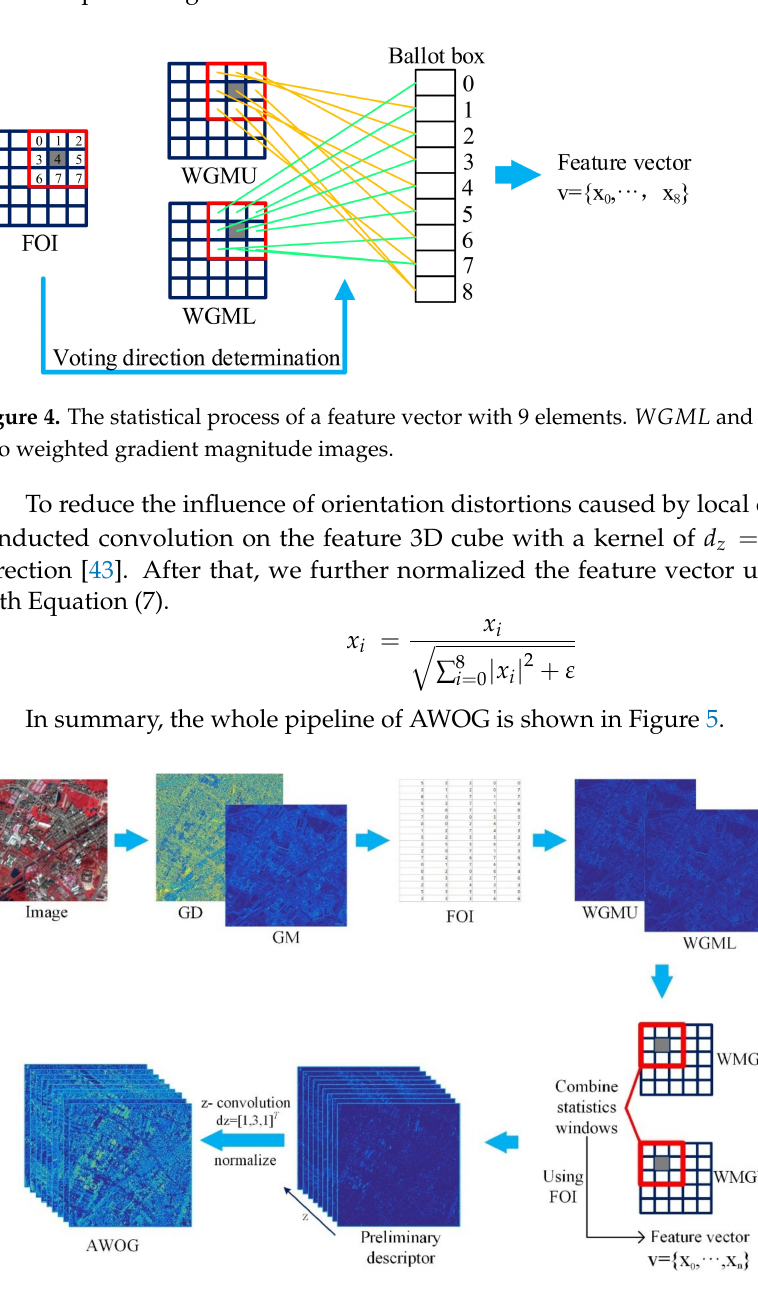
Figure 5. The processing pipeline of AWOG